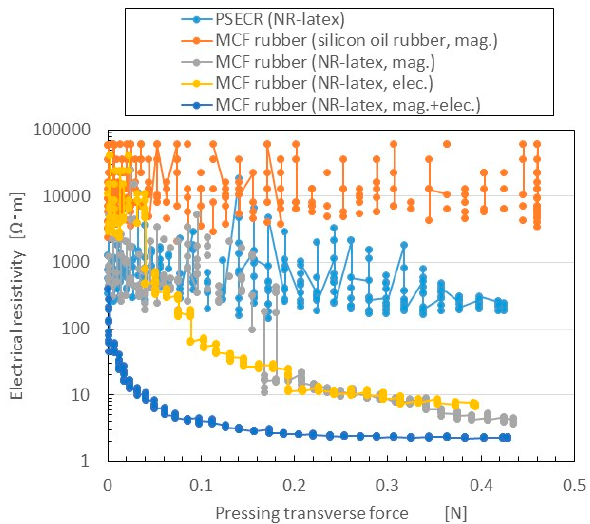
Figure 9. Electric characteristics of MCF rubber made by the new method in the case of NFE, compared among three electric and magnetic field conditions, and among NR-latex, silicon oil, and PSECR